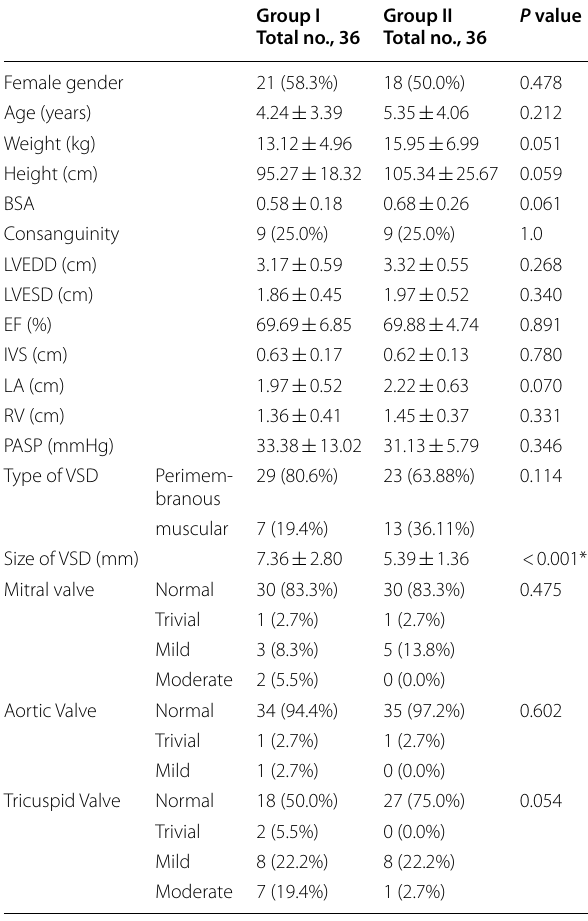
Table 1 Comparison between group I and group II regarding preoperative